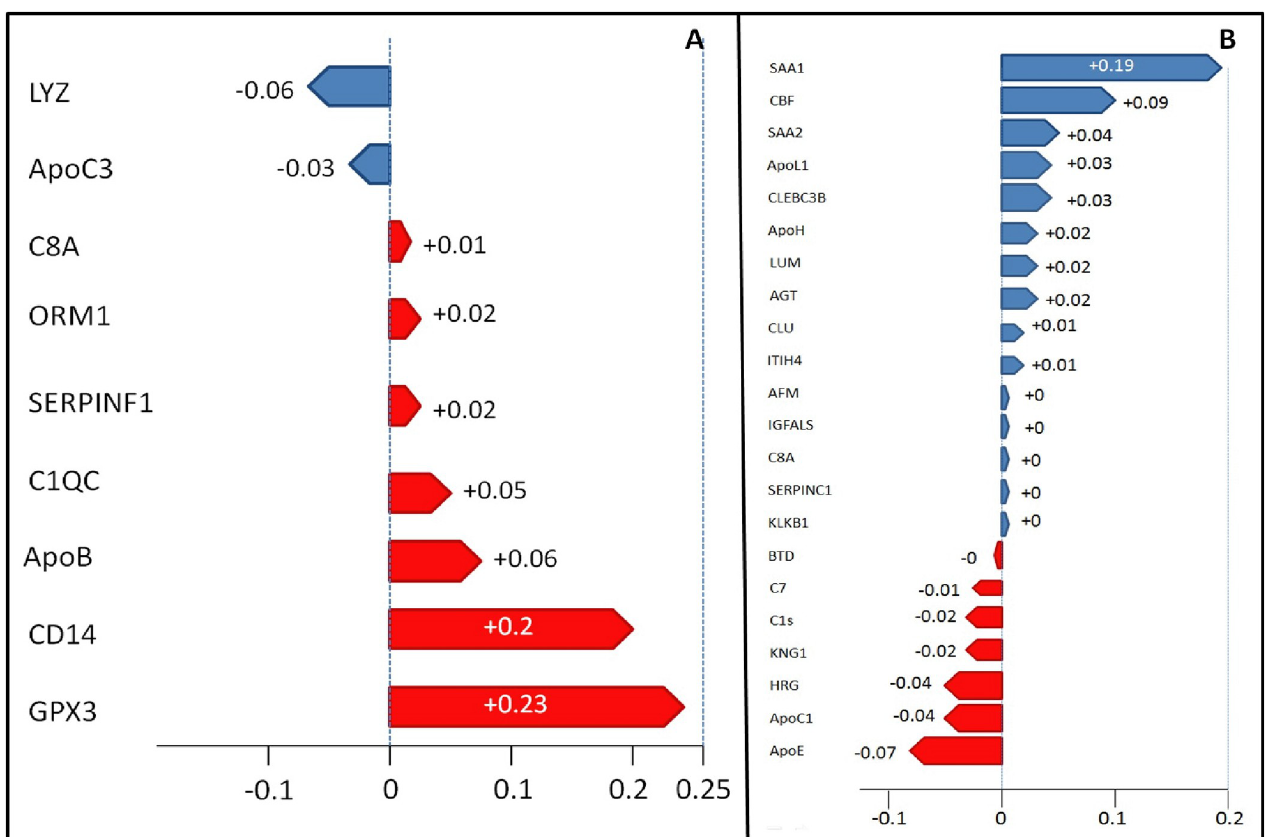
Fig 2. Shap values graphics. A) blue = proteins expressed in patients with SOFA � 6, red = proteins expressed in patients with SOFA > 6. B) blue = proteins expressed in patients survivors, red = proteins expressed in patients non-survivors.